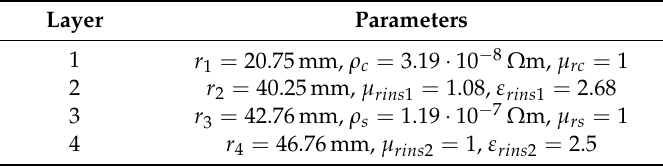
Table 4. Geometrical and material parameters for Case Study #2. Source